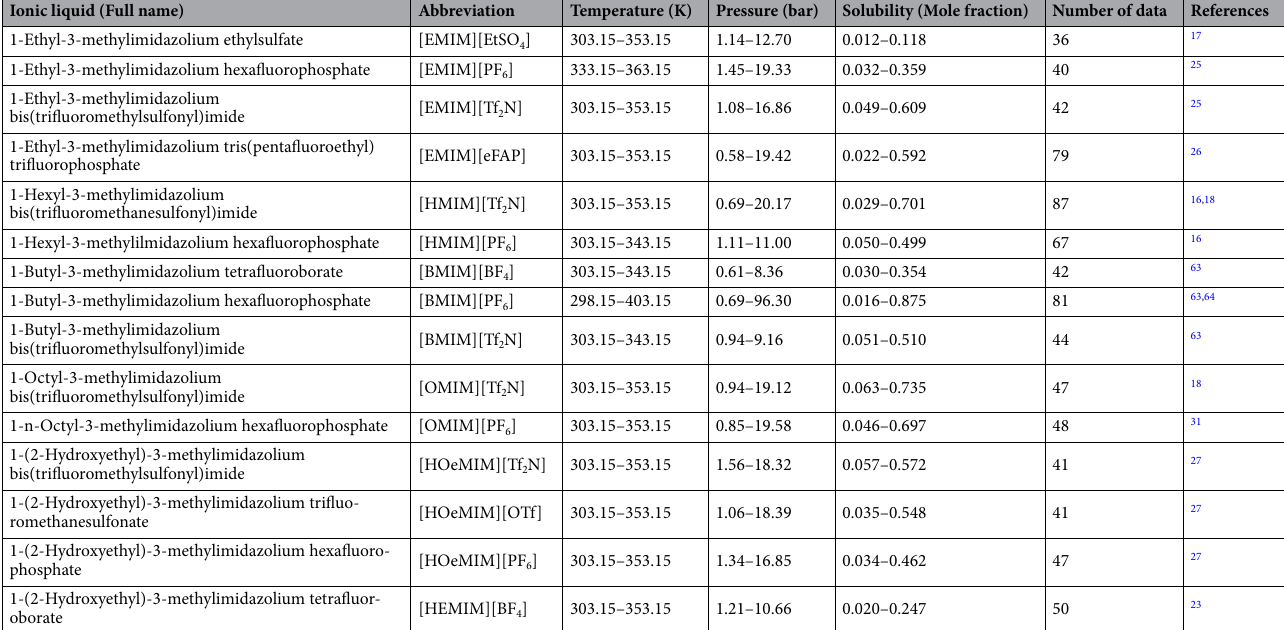
Table 1. The range of operating conditions during absorbing H 2 S molecules by different ionic liquids.